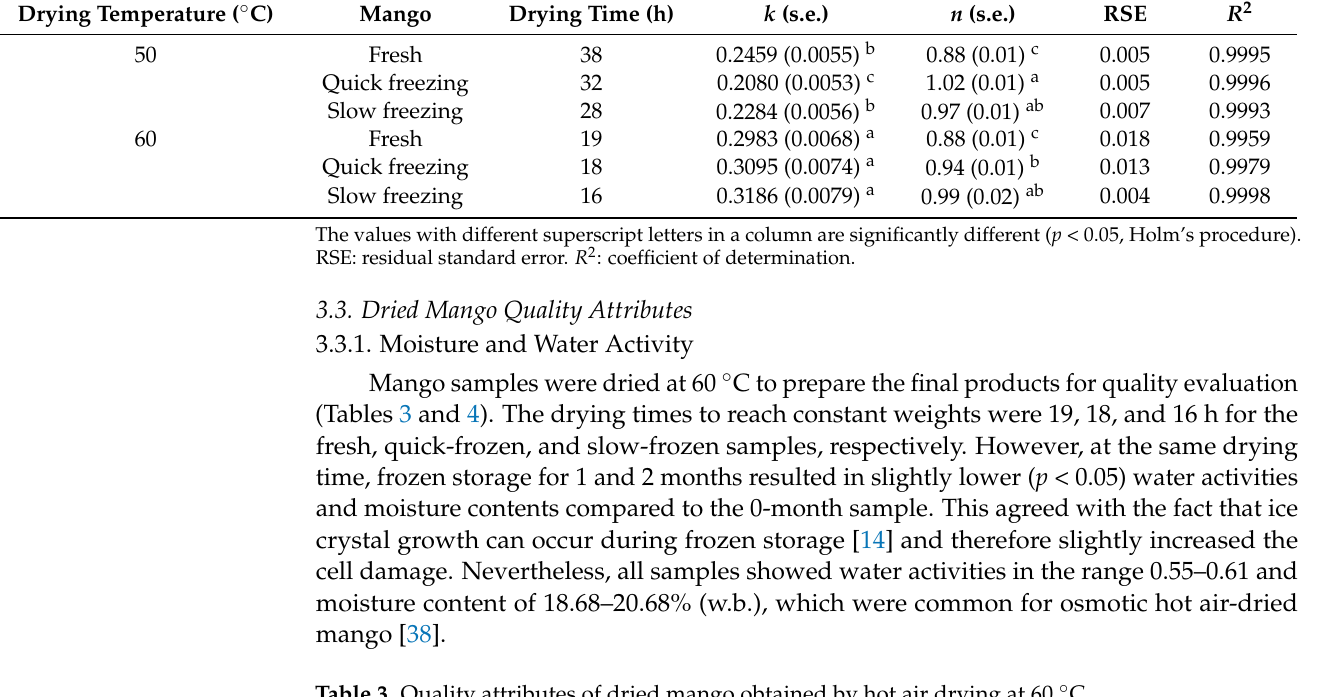
Table 3. Quality attributes of dried mango obtained by hot air drying at 60 ◦